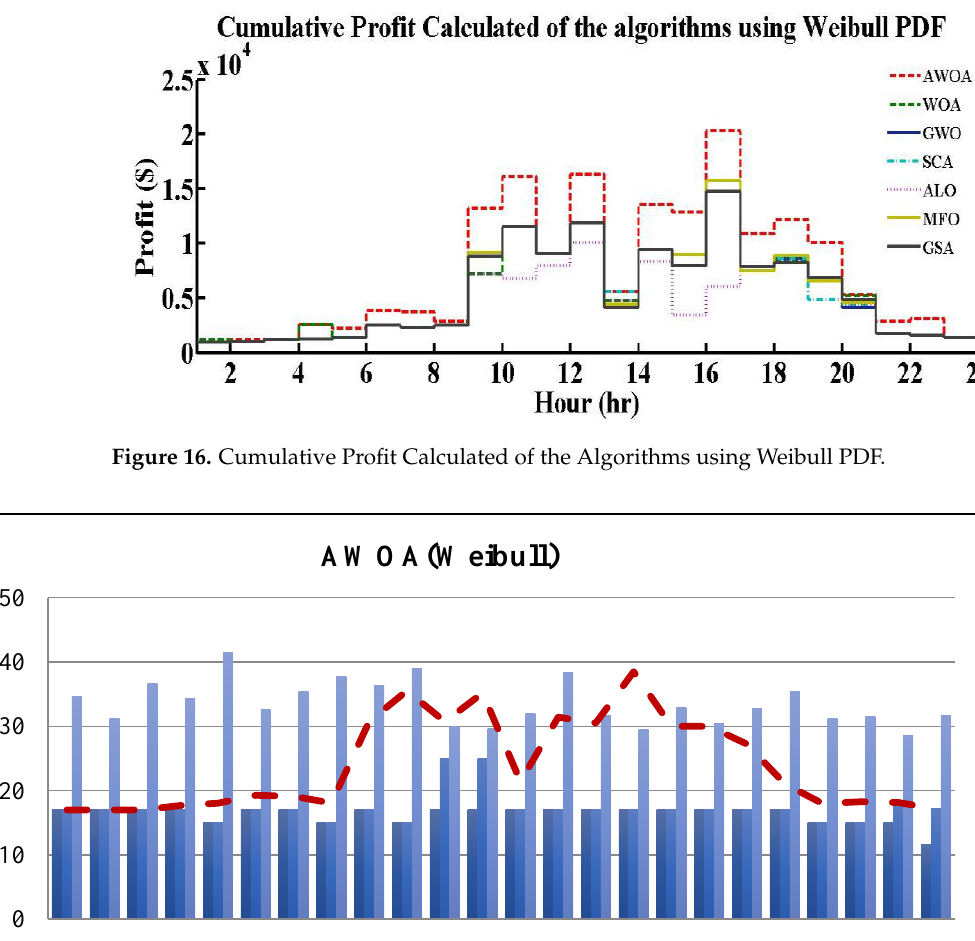
Figure 17. AWOA (Weibull Distribution) Block Bid Price and MCP.